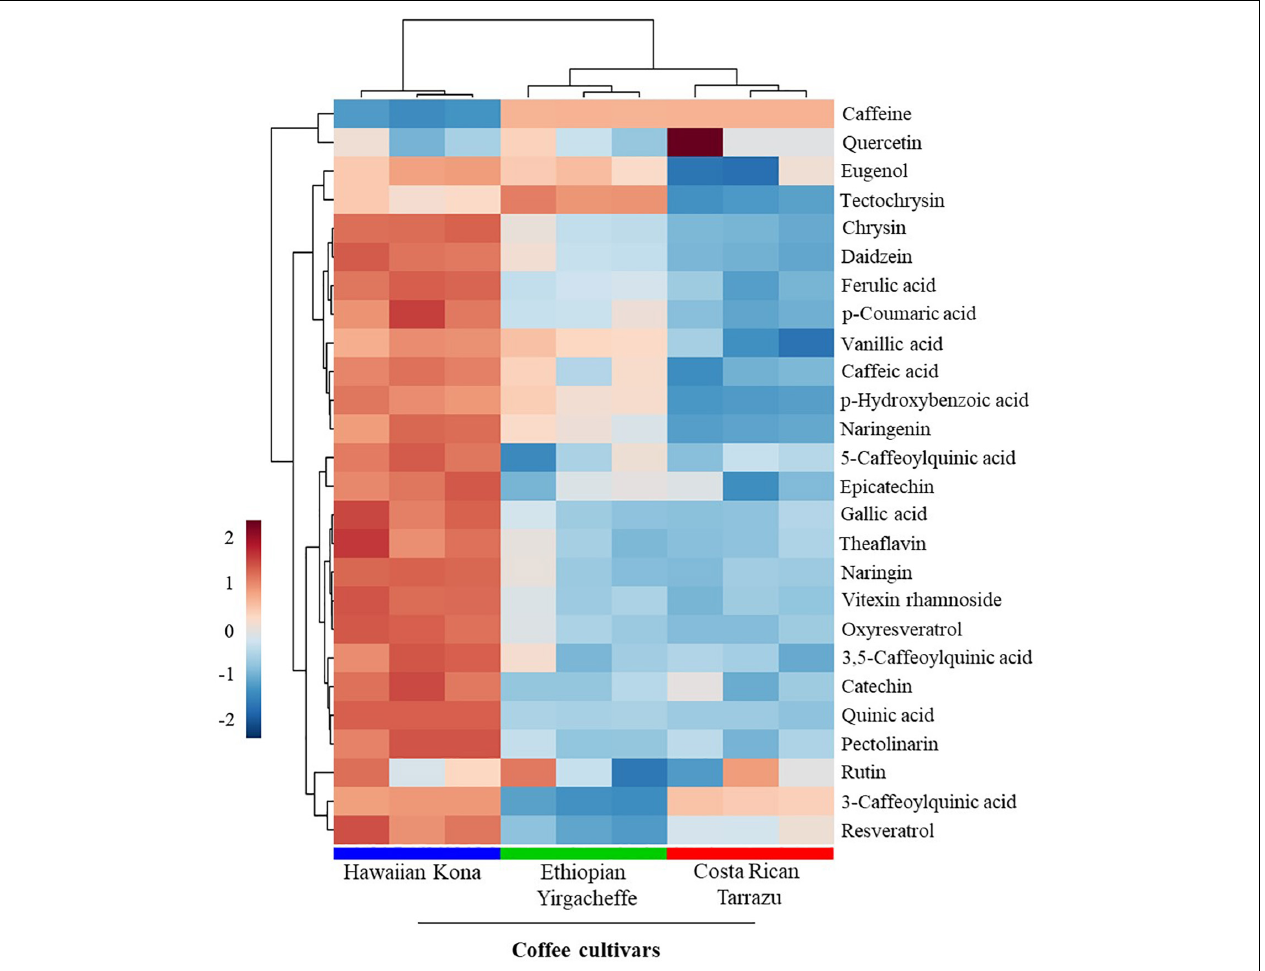
FIGURE 5 | Relative intensities of metabolites with known anti-inflammatory activities in spent coffee grounds. In the heatmap, red represents higher relative abundance, whereas blue represents lower relative